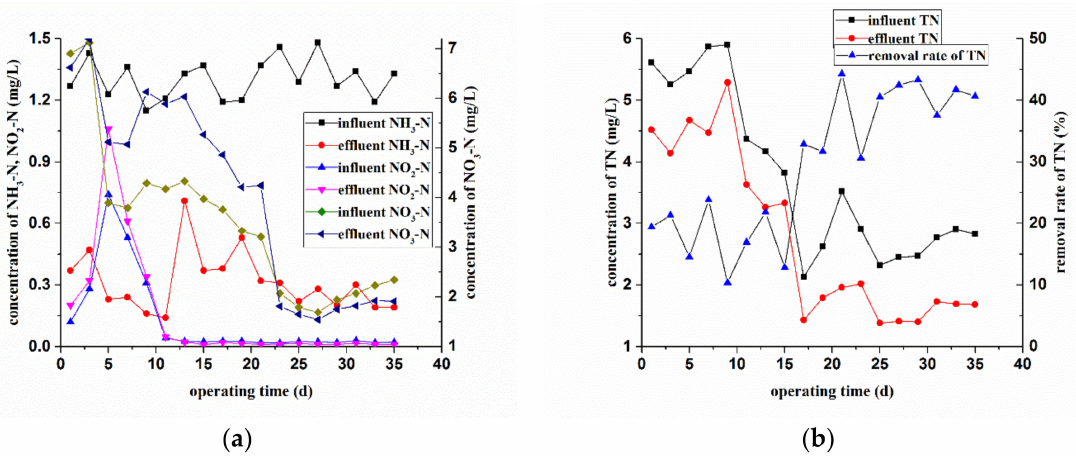
Figure 3. Transformation of nitrogen in different forms ( a ) and TN (total nitrogen) removal performance ( b